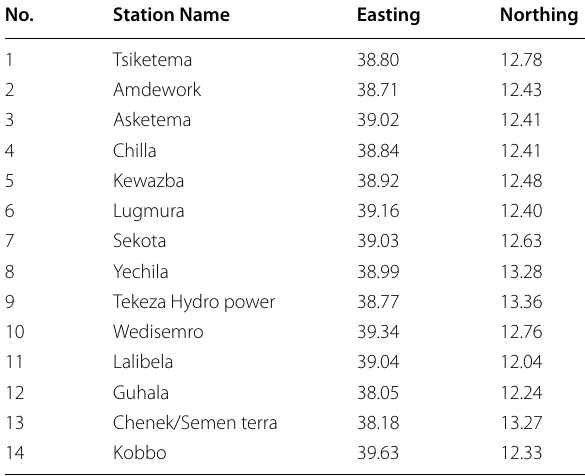
Table 1 List of weather stations and their geographic